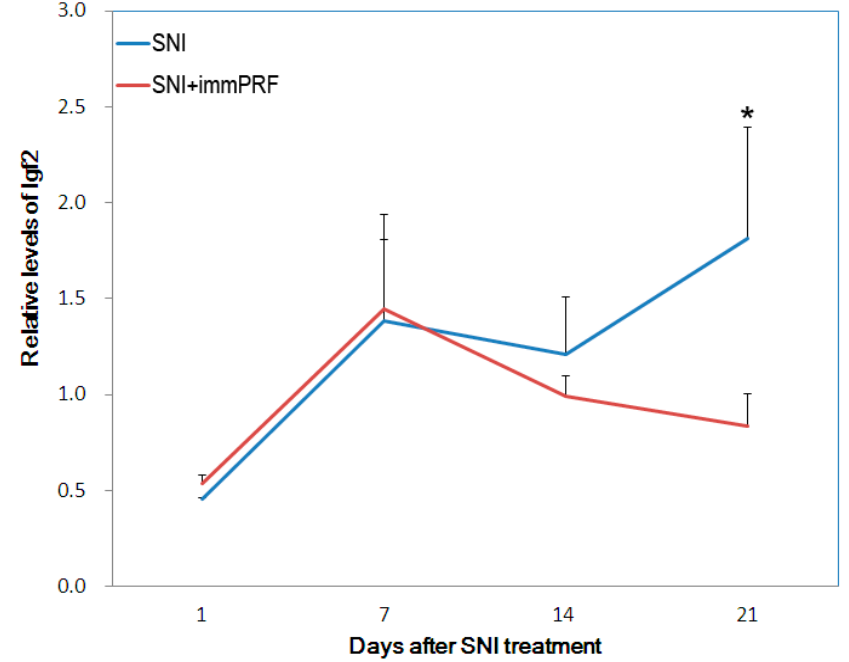
Figure 3. Validation of Igf2 expression by quantitative real-time PCR. Relative expression of Igf2 in dorsal horns (L4–L6) was quantified and normalized to individual expression of GAPDH. Each quantitation was independently triplicated. SNI, spared nerve injury; PRF, pulsed radiofrequency. Blue line, SNI group; red line, SNI + immPRF group. * p < 0.05.